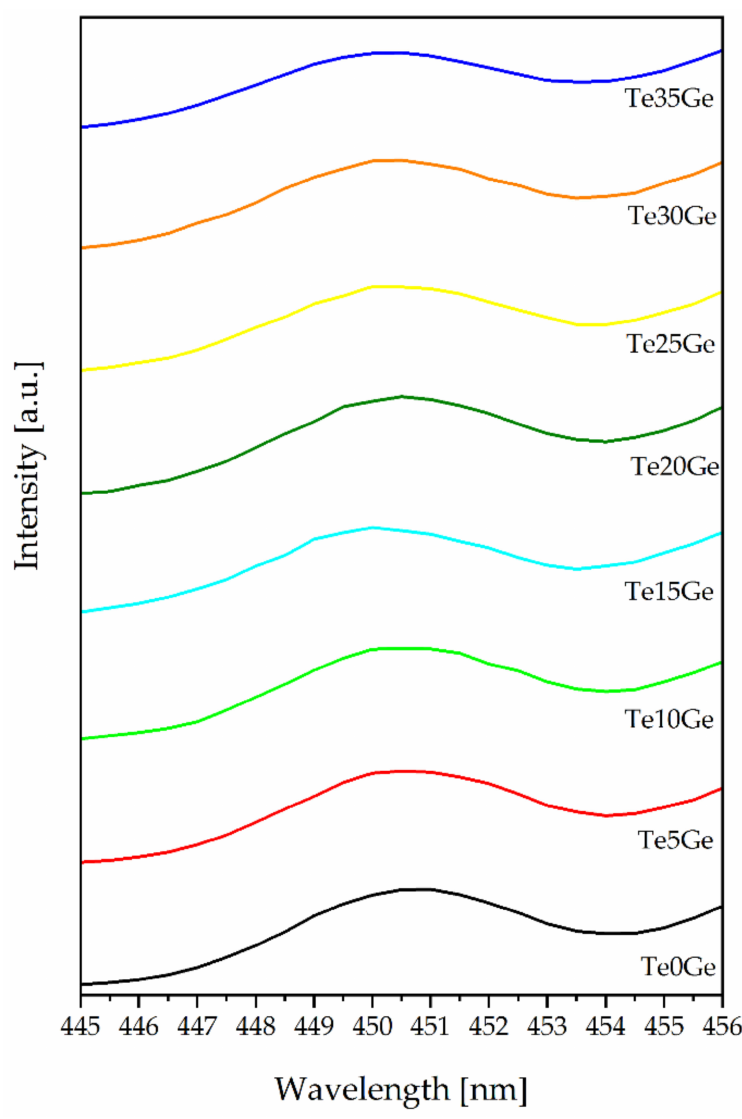
Figure 10. Phonon sidebands (PSB) of Eu 3+ ions in glasses with various TeO 2 /GeO 2 molar